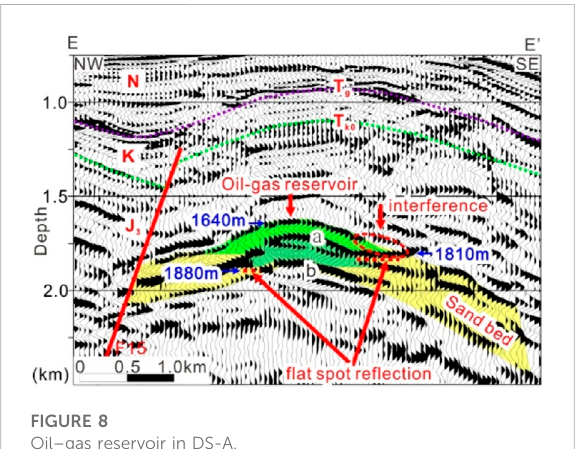
FIGURE 8 Oil – gas reservoir in DS-A.